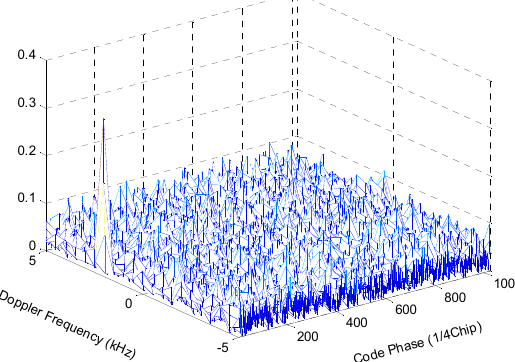
Figure 8. Frequency and time search results for BOC(15,2.5).